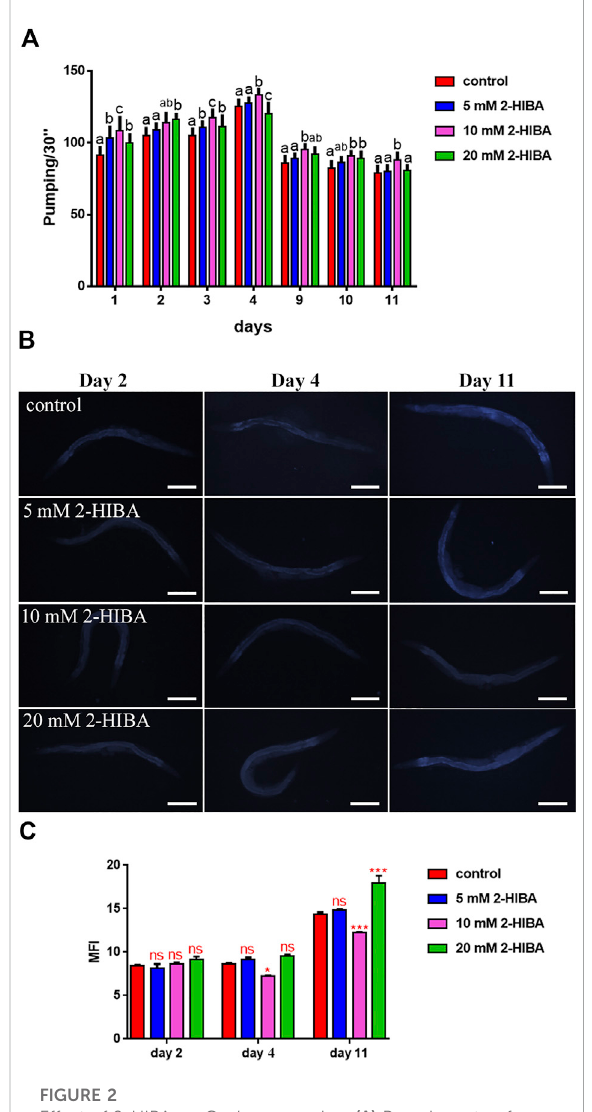
FIGURE 2 Effect of 2-HIBA on C. elegans ageing. (A) Pumping rate of worms at different stages after 2-HIBA treatment from embryo hatching and measured for 30 s. Pharyngeal contractions were determined from the mean of 10 worms for each bacterial strain. Worms fed heat-killed OP50 without 2-HIBA supplementation were used as controls (control: untreated worms). Different letters indicate statistically signi fi cant differences ( p < 0.05). (B) Fluorescence microscopy of auto- fl uorescent lipofuscin granules in C. elegans supplemented with 10 mM 2-HIBA. (C) Mean Fluorescence Intensity related to lipofuscin accumulation. Ten worms were used for each measurement (** p < 0.01). Scale bar = 100 μ superoxide dismutase 3 (SOD-3) and glutathione s-transferase 4 detoxifying (GST-4) enzymes and the mitogen-activated protein kinase (MAPKK) SEK-1. In worms treated with 5 or 20 mM 2-HIBA, a general reduction in expression of genes involved in response to oxidative stress was observed, as